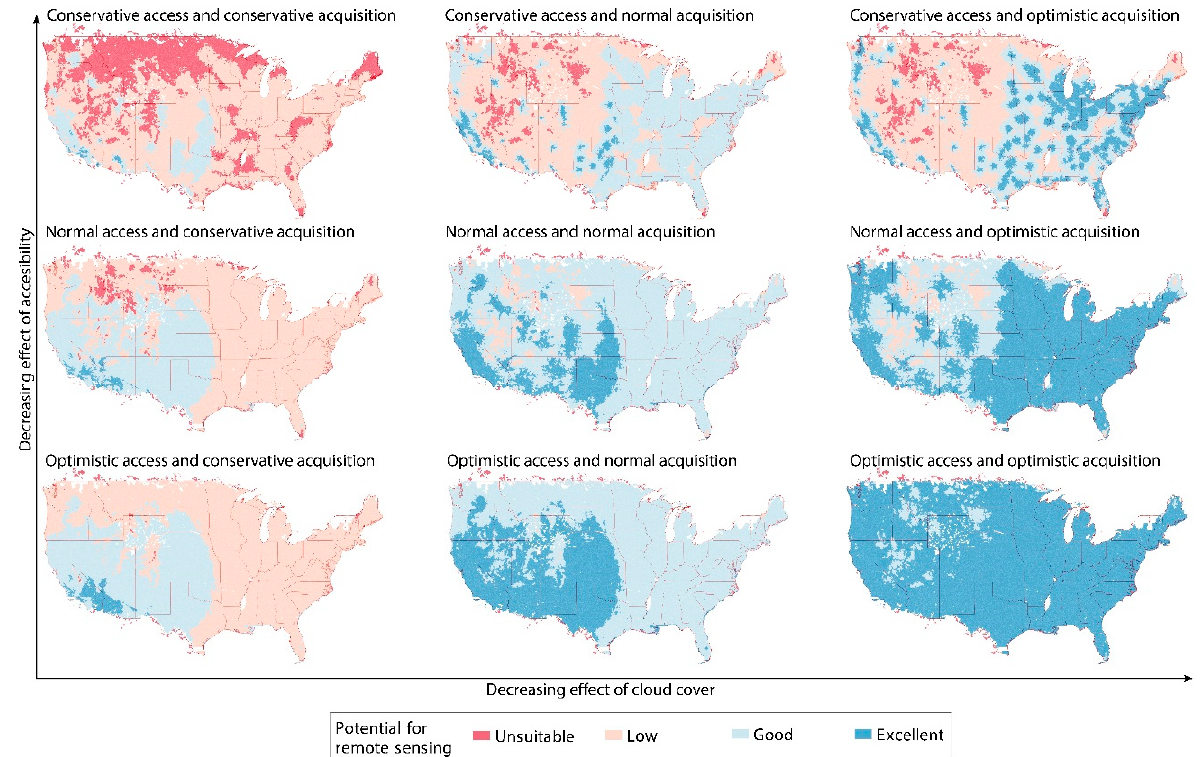
Figure 4. Modeled maps of the potential of remote sensing for data collection and monitoring of watersheds under various cost-payoff assumptions. As the effect of cloud cover decreases (more cloudy days are acceptable), more cloudy areas display higher potential. As the effect of access decreases (longer travel times are acceptable), more remote areas display higher potential. Thin red lines are state boundaries.